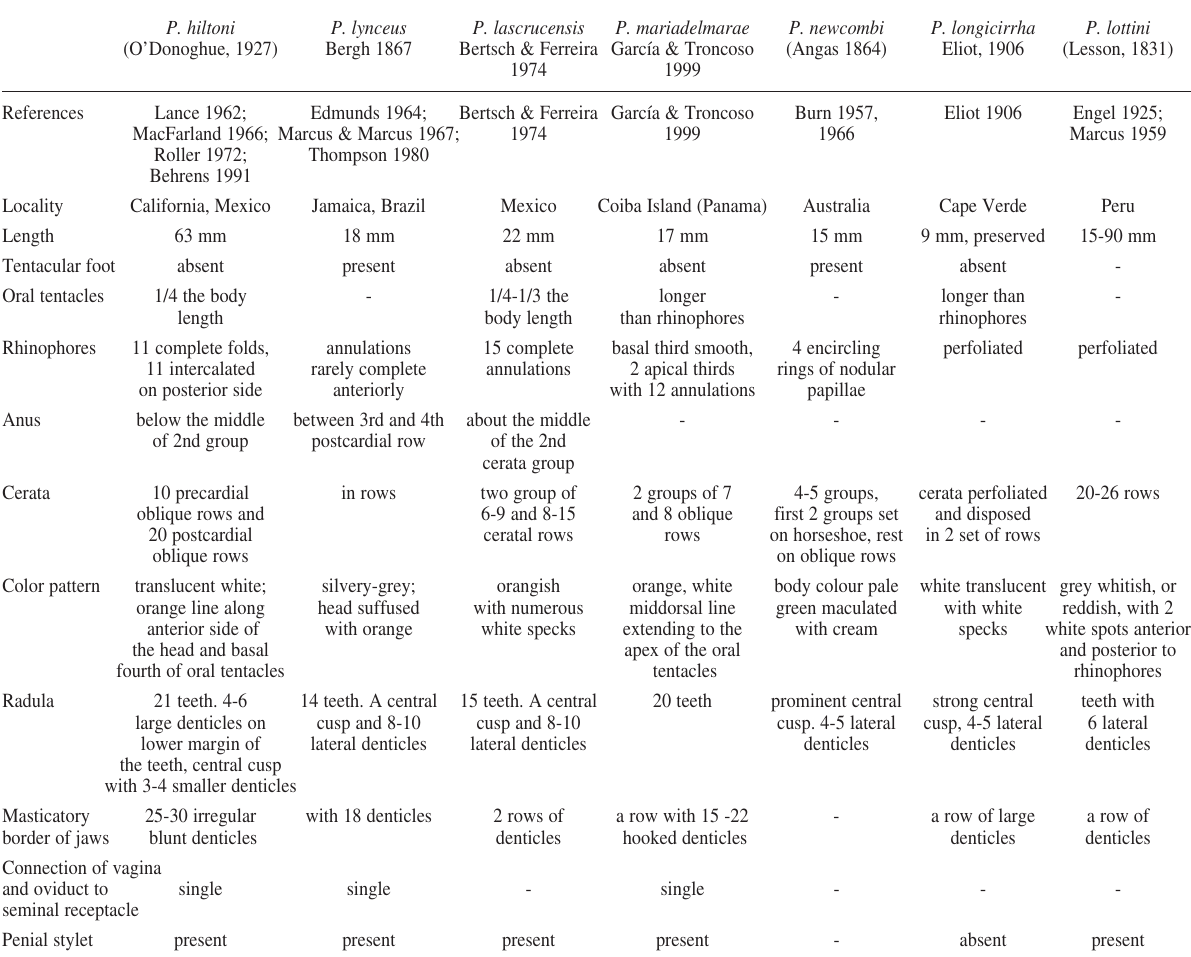
Table 1 (Cont.).- Comparative table of Phidiana